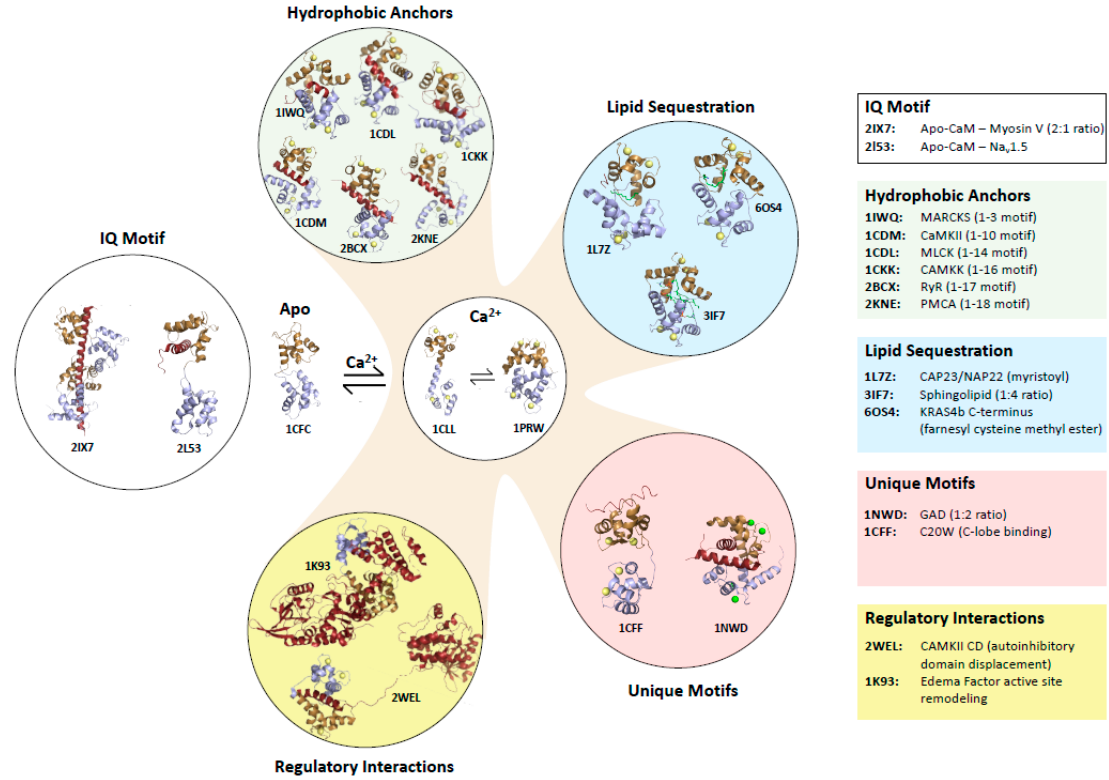
Figure 1. Diversity of calmodulin target binding. Structures of canonical and non-canonical calmodulin:target complexes selected to illustrate diverse modes of binding. PDB accession codes for each structure are indicated along with the target name and motif type. The calmodulin C-terminal and N-terminal lobes are coloured brown and blue, respectively, and target peptides and proteins are dark red. Lipid components of targets are green. Acronyms are: MARCKS (myristoylated alanine-rich C kinase substrate), CaMKII (Calmdoulin Kinase II), MLCK (Myosin Light Chain Kinase), CaMKK (Calmodulin Kinase Kinase), RyR (Ryanodine Receptor), PMCA (Protein Misfolding Cyclic Amplification), CaMKII CD (CaMKII C-terminal domain), C20W (the C20W peptide from the plasma membrane calcium pump), GAD (Glutamate Decarboxylase). CaM:target stoichiometry is indicated in cases where it is not 1:1 (e.g., one molecule of CaM binds two GAD or four sphingolipids, and two CaM peptides bind a single myosin peptide).